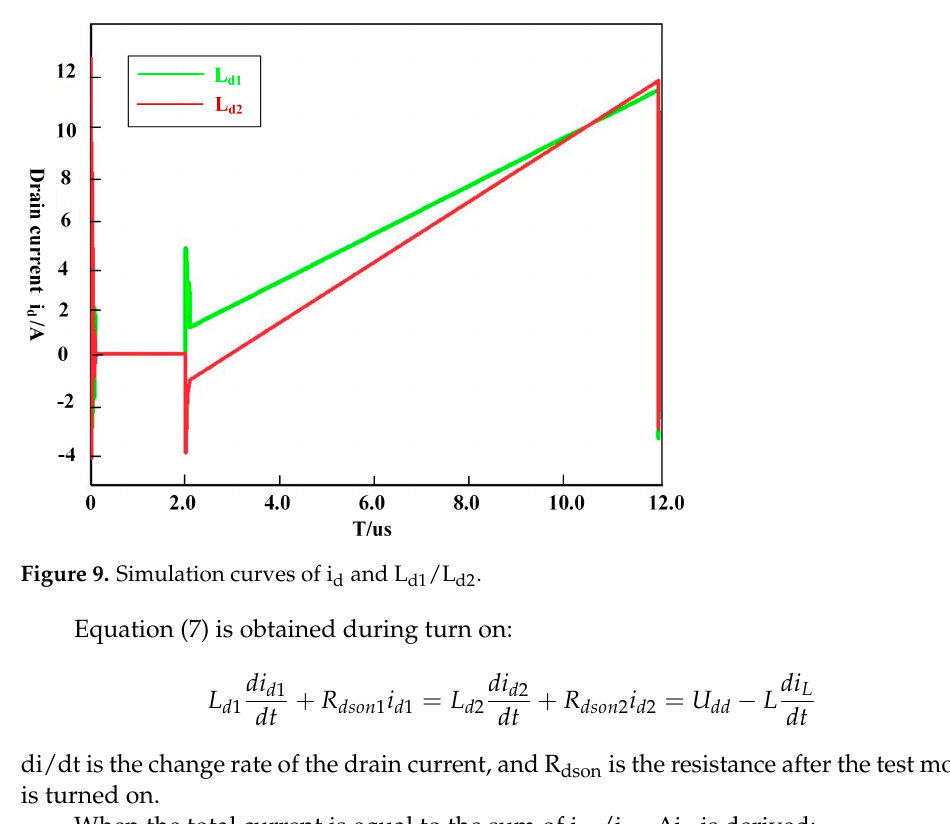
Figure 8. Simulation curves of i d and the maximum, standard, average, minimum values of L d .